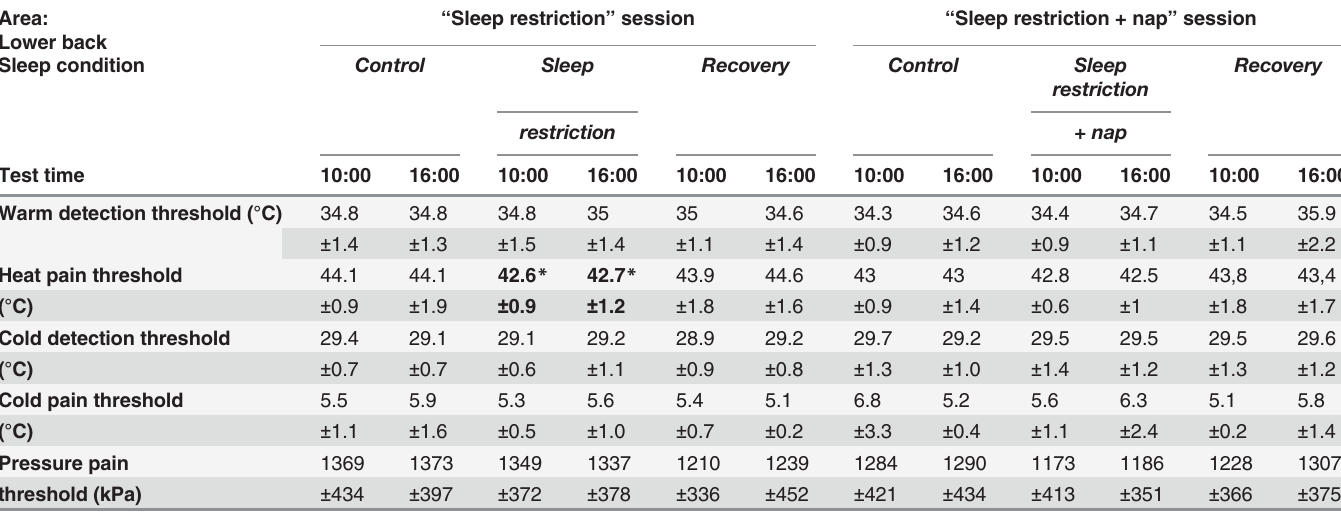
Table 1. Lower back quantitative sensory testing pro fi le after sleep restriction without or with napping. Area: “ Sleep restriction ” session “ Sleep restriction + nap ” session Lower back Sleep condition